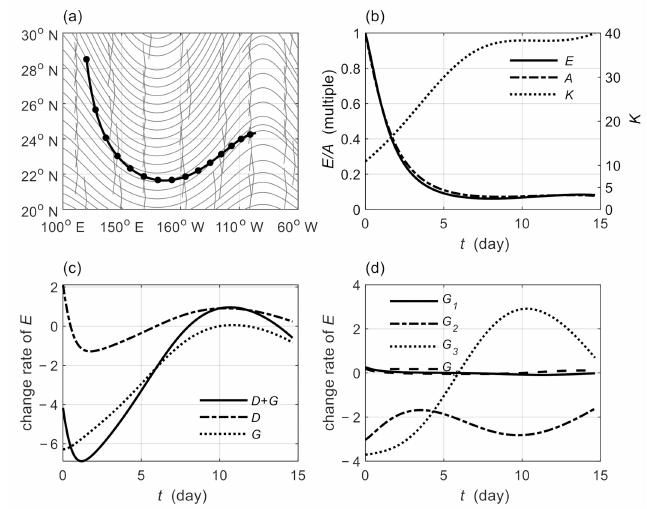
Figure 2. Ray path (solid black dots denoting the one day interval) of the wave (the source is set to 120 ◦ E, 28.5 ◦ N) with a period T = 10 days ( a ). The variations in wave energy ( E , solid line), amplitude ( A , dash-dotted line) and the total wavenumber ( K , dotted line) along the ray ( b ). The variations in the divergence of the group velocity (dash-dotted line, shortened as D ), the energy budget from the basic flow (dotted line, shortened as G ) and the sum of them (change rate of wave energy) along the ray ( c ). The variations in the four components of the energy budget from the basic flow (shortened as G 1 , G 2 , G 3 and G 4 , respectively, and their sum equals G ) along the ray ( d ). D and G ( G 1 , G 2 , G 3 and G 4 ) have been magnified 10 6 times to glory the